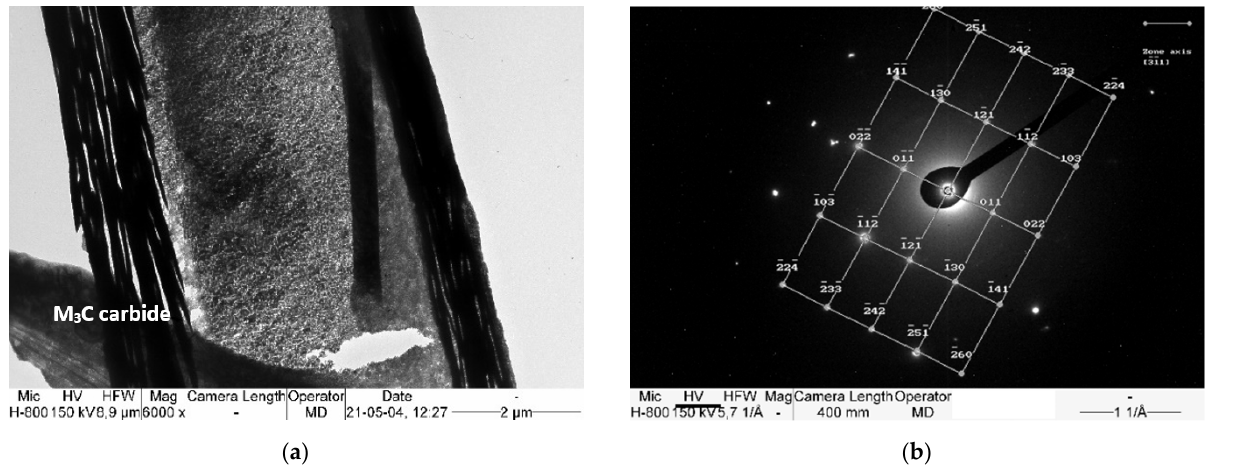
Figure 7. ( a ) Thin M 3 C carbide plates in the austenite matrix. ( b ) Diffraction pattern obtained from (Fe,Mn) 3 C carbide with zone axis [ 3(cid:3364)1(cid:3364)1 ] showed in ( a ). TEM. (Fe,Mn) 3 C carbide with zone axis [311] showed in ( a ).